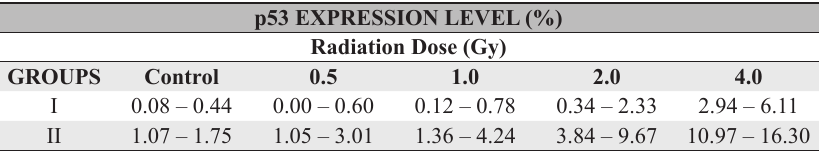
Interval of confidence of p53 protein expression level for different absorbed doses and control (non-irradiated).